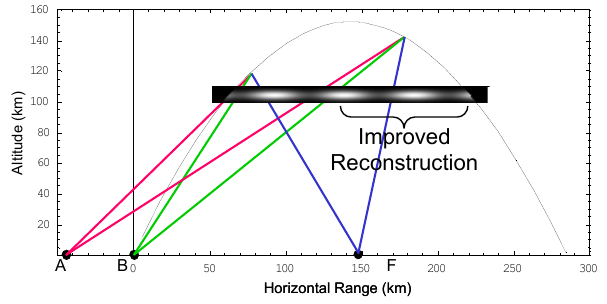
Figure 15. SVD reconstruction of the test example using data from three receivers, 1082 samples per receiver and a reconstruction grid with 1 km (H) x 1 km (V) cell size. The addition of the data from the third receiver yields the improved reconstruction region.